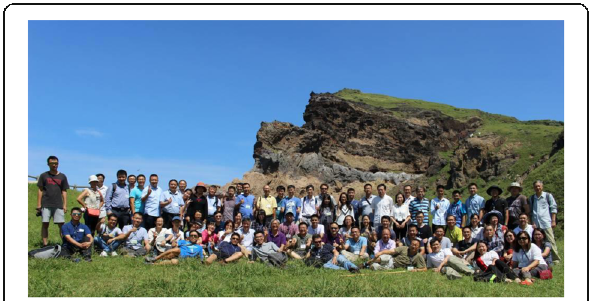
Fig. 2 Group photo at the Ts ū tenky ō Arch, Oki Islands